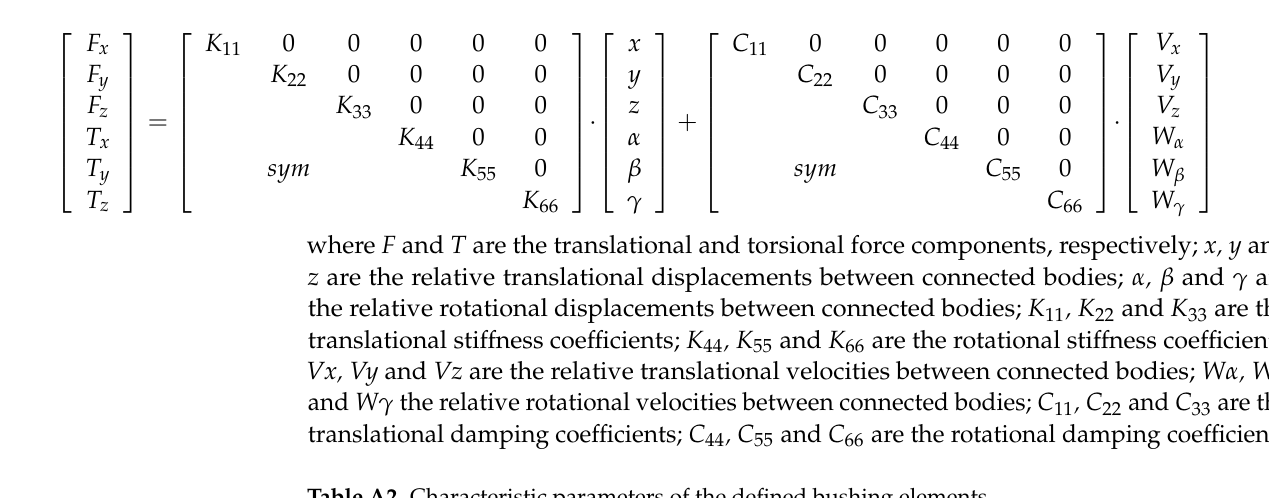
Table A2. Characteristic parameters of the defined bushing